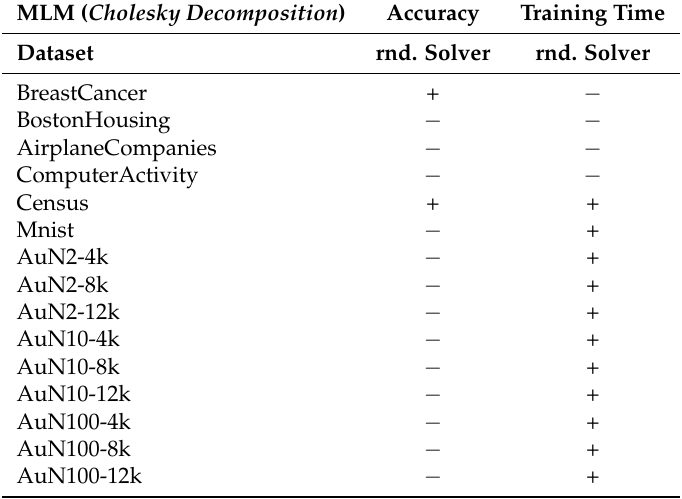
Table 4. Summary of comparison between Cholesky decomposition and randomized solvers for the MLM. Symbols + and − indicate that the randomized solver is better/worse than the Cholesky decomposition